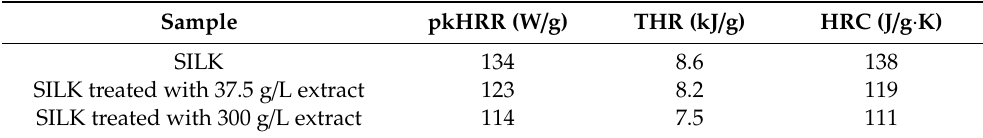
Table 24. Results from microscale combustion calorimetry for silk before and after the treatment with